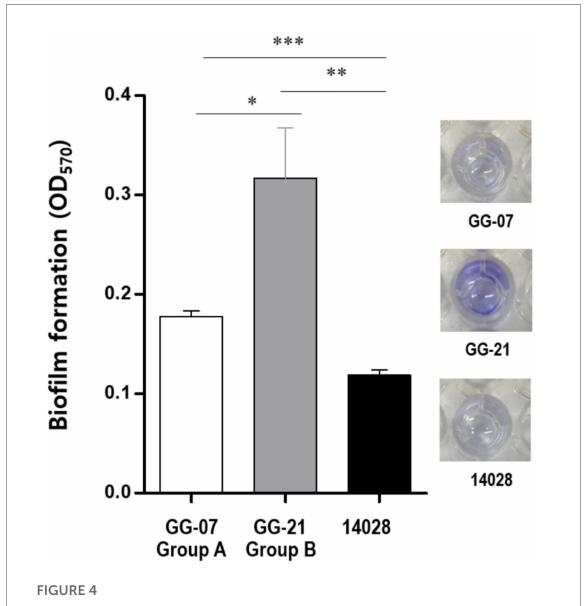
FIGURE4 Biofilm formation of S . Bareilly. Biofilms attached to the plastic surface were stained with Crystal Violet after 5 days incubation at 28 ◦ C. All experiments were independently replicated in triplicate. NS, no significance; ∗ p < 0.05; ∗∗ p < 0.005; ∗∗∗ p <